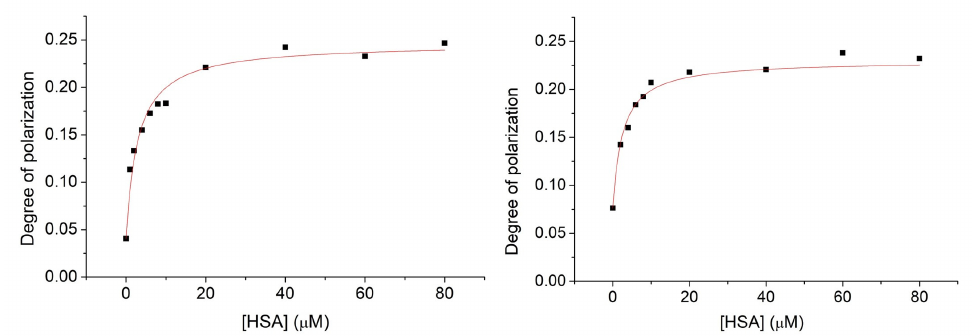
Figure 7. Fluorescence polarization spectra of nitroxide 1 (1 μ M) in the presence of HSA with increasing concentration within the range of 0–80 μ M. Experiments were performed in the absence ( left ) and in the presence of cavitand 2 ( right ).